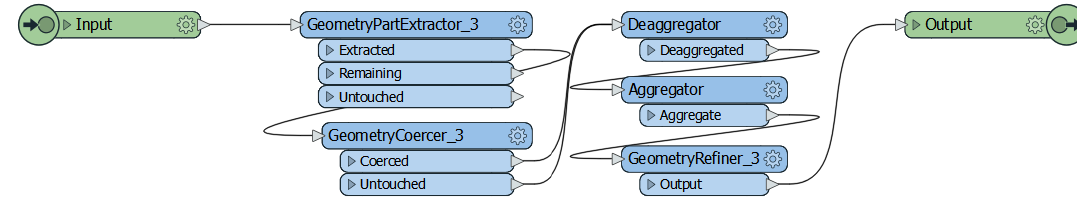
Figure 16. “ConvertGeometry” custom transformer workflow.